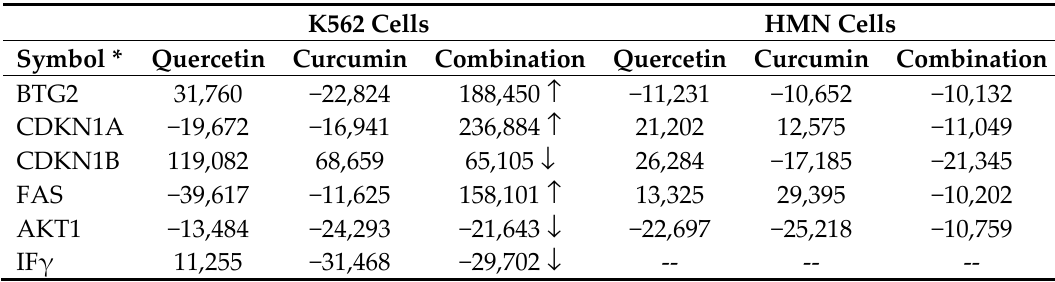
Table 1. Gene expression analysis results for signal pathways in quercetin and curcumin treated K562 and HMN cells. Fold-changes of studied genes are given.